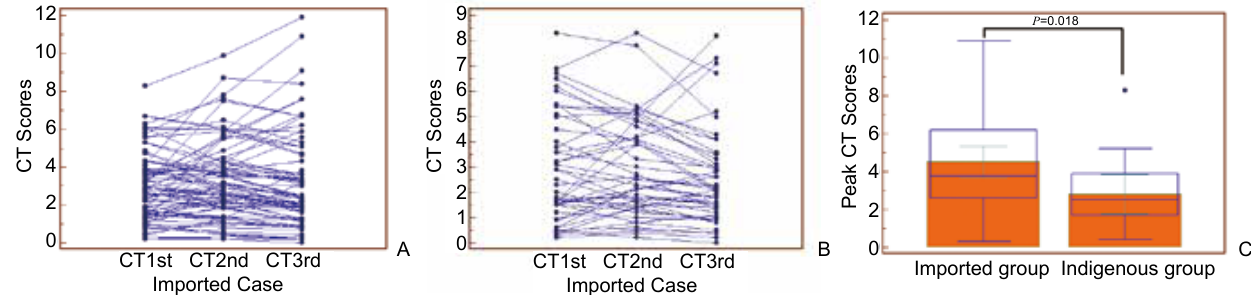
CT1st CT2nd CT3rd Imported Figure 2 (A and B) Dot and line diagram of CT scores on 3 sequential CT scans between imported cases and indigenous cases. (C) Box and whisker plots of peak CT scores in 55 COVID-19 cases.